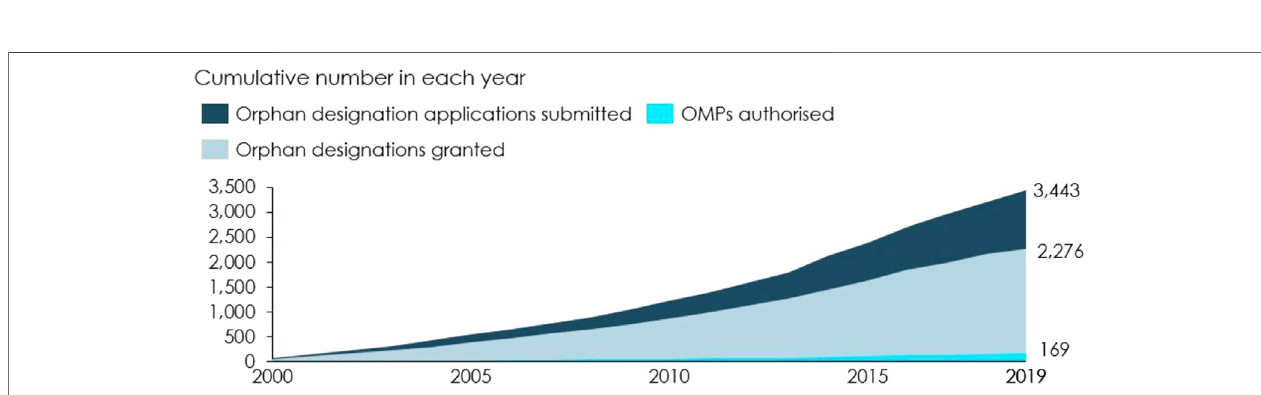
FIGURE3| Applications submitted, designationsgrantedand authorisedOMPscumulative.Note:Thesenumbersincludeapplicationsandauthorised OMPsthat have been withdrawn. Source: European Commission (2020a) and European Medicines Agency (2020).